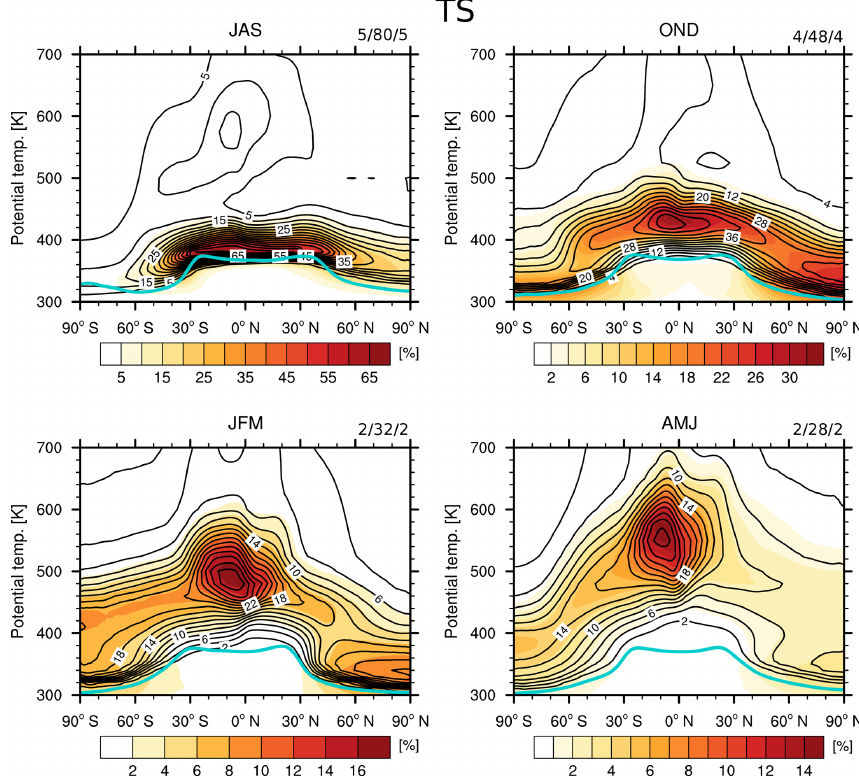
Figure 5. As in Fig. 4 but for the TS